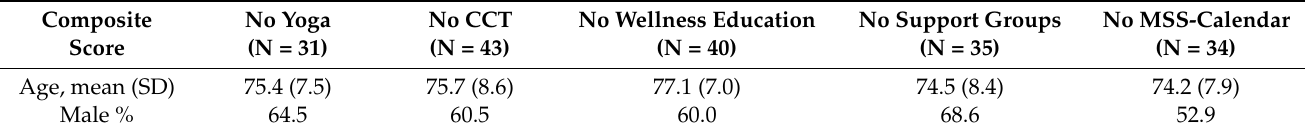
Table 1. Participant demographics at baseline by study arm.